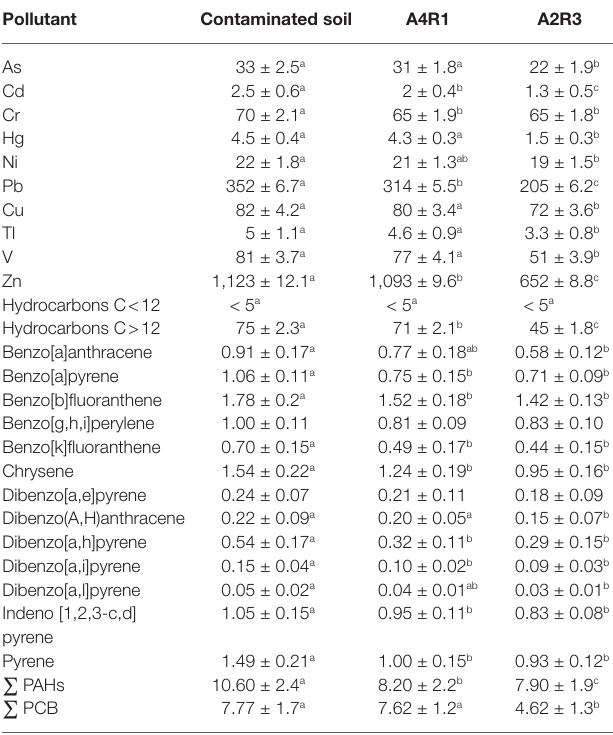
TABLE 1 | Metals and organic pollutants (mg/kg) in control soil (pluricontaminated soil) and in the two treated soils (A4R1, A2R3) at the end of the experiment (8